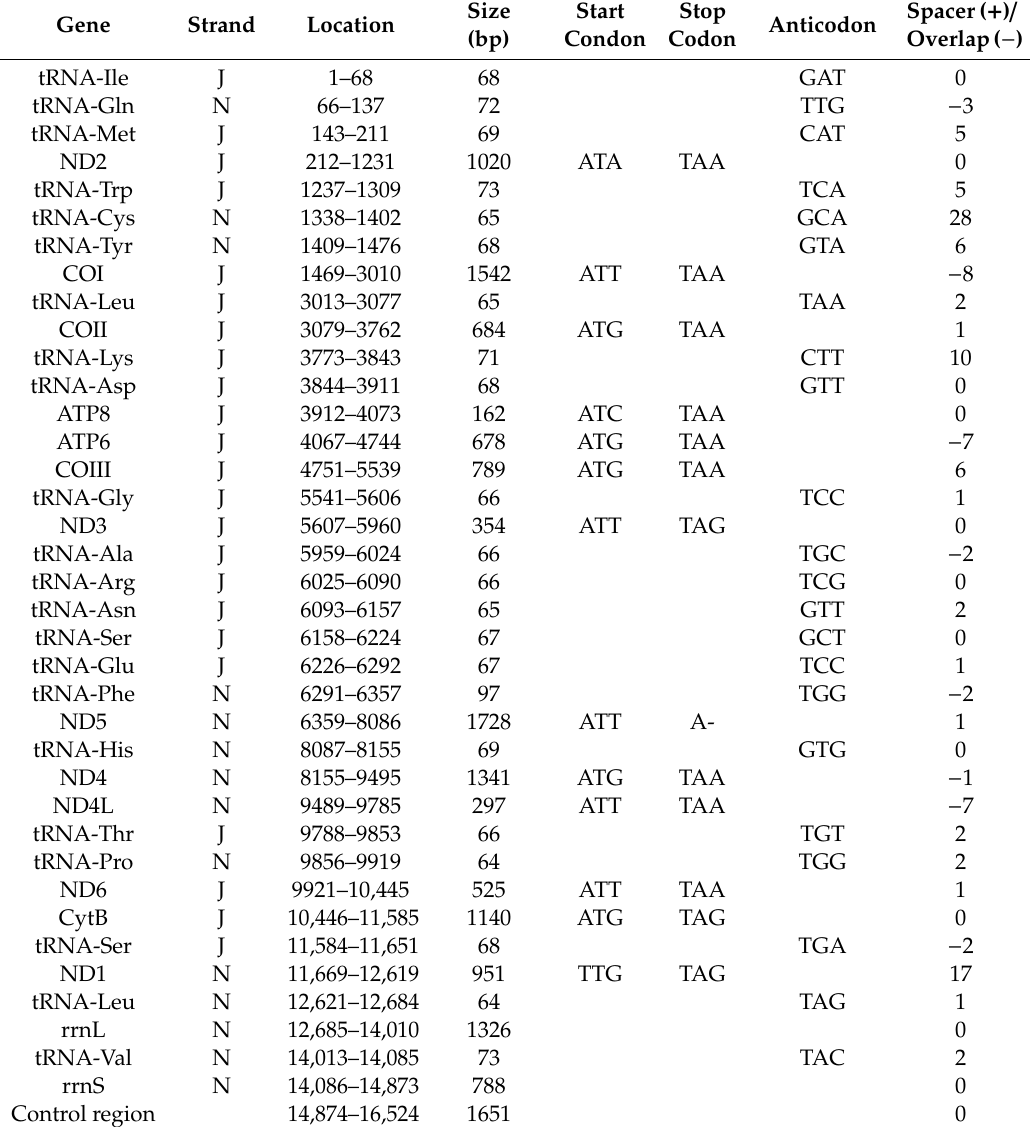
Table 1. Organization of H. sinicus